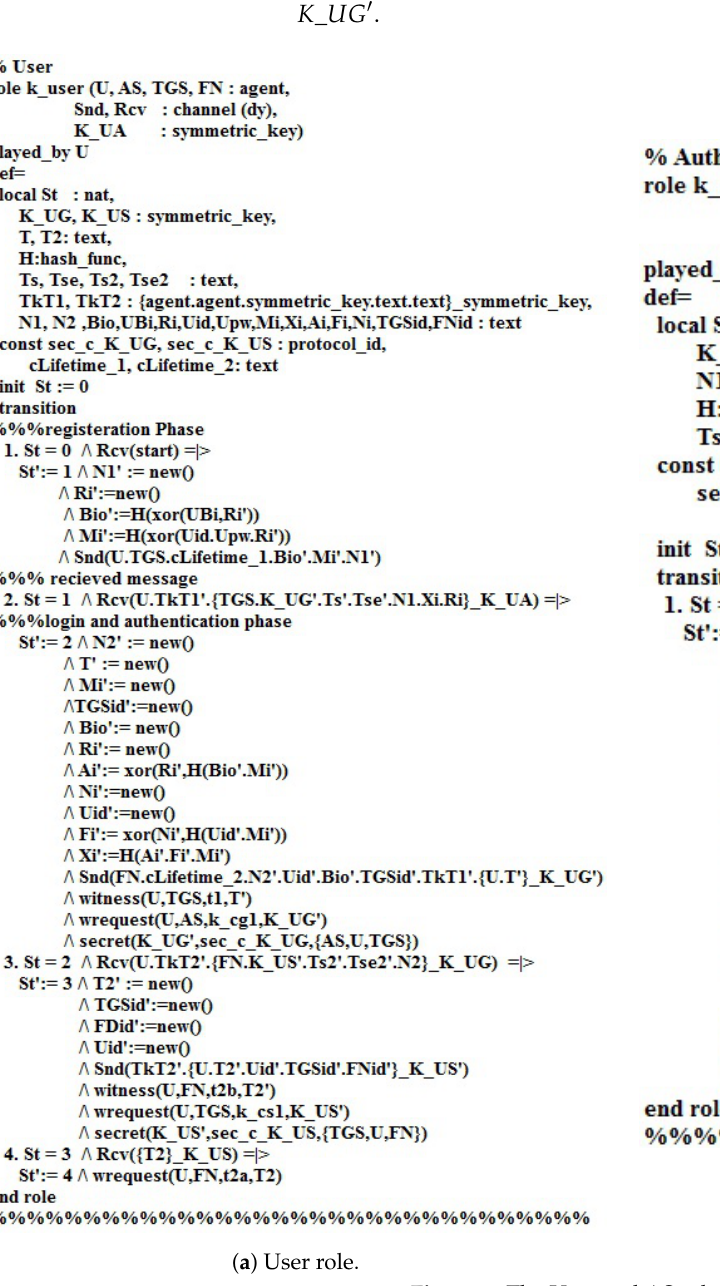
Figure 8. The User and AS roles in